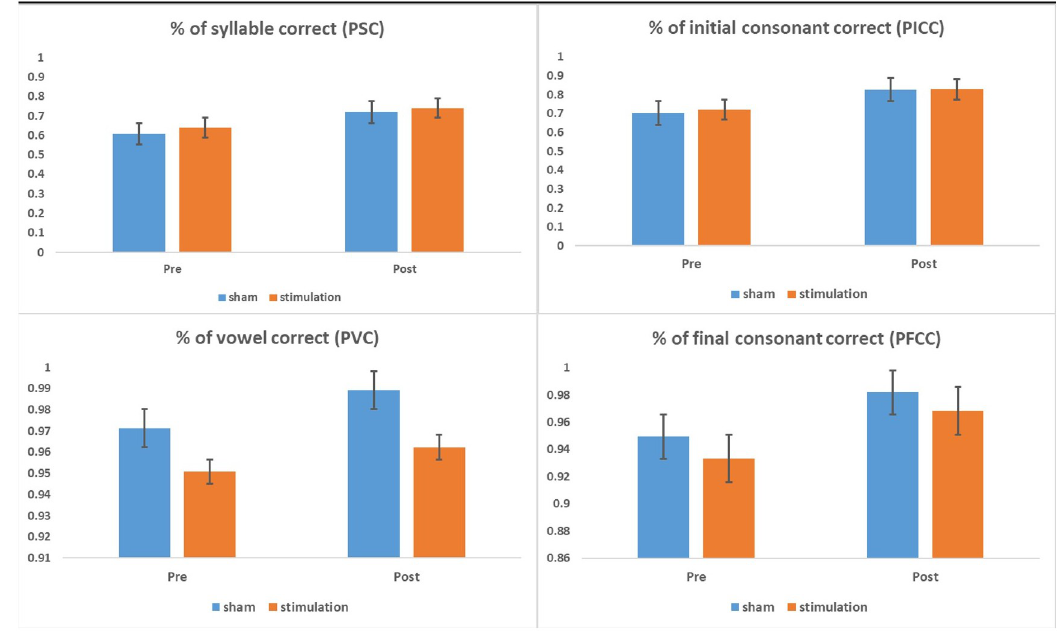
Fig 4. Mean (and standard error) perceptual ratings at the word level assessed using the Hong Kong Cantonese Articulation Test (HKCAT) for the stimulation and sham groups before and after treatment. Note: % = percentage.